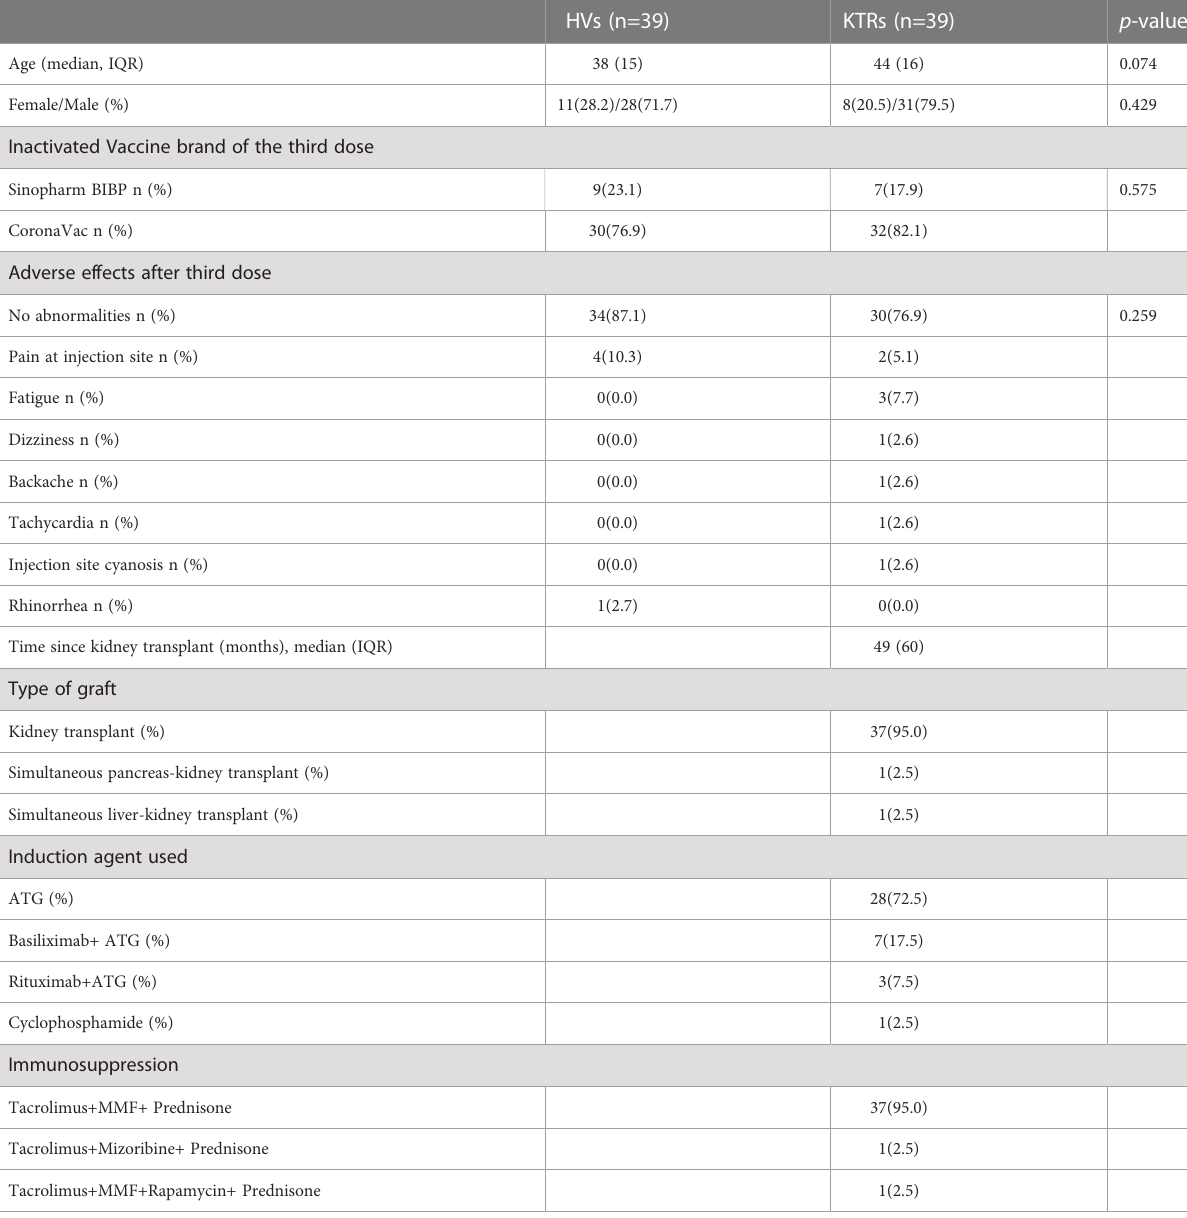
TABLE 1 The baseline characteristics and adverse events of enrolled healthy volunteers and kidney transplant